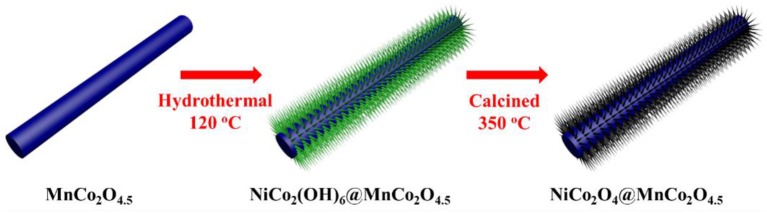
Schematic illustration of the procedure to synthesize NiCo2O4@ MnCo2O4.5 composites.